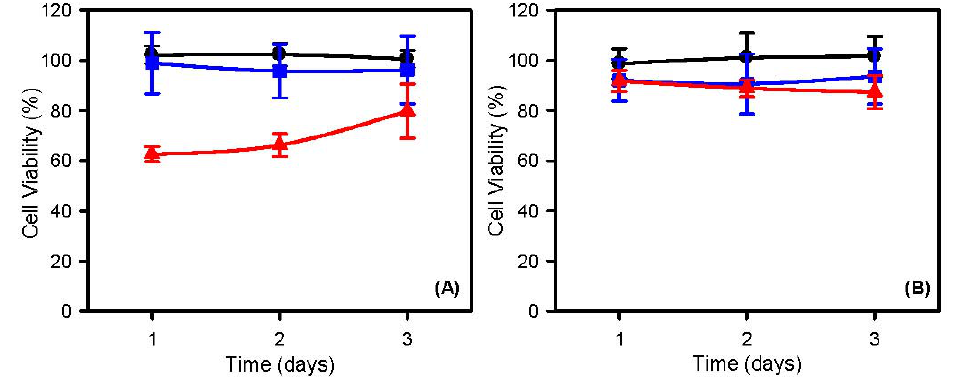
Figure 4. Cytotoxicity of unloaded folate-conjugate submicrogels (F-SubMGs). Cell viablitiy of ( A ) MCF7 and ( B ) HeLa. Without F-SubMGs ( ● ) or with unloaded F-SubMGs at a concentration 80 µg/mL ( ■ ); 400 µg/mL ( ▲ ); Concentration of F-SubMGs was in accordance with data of Table 2. Data were shown as mean ± SD ( n =